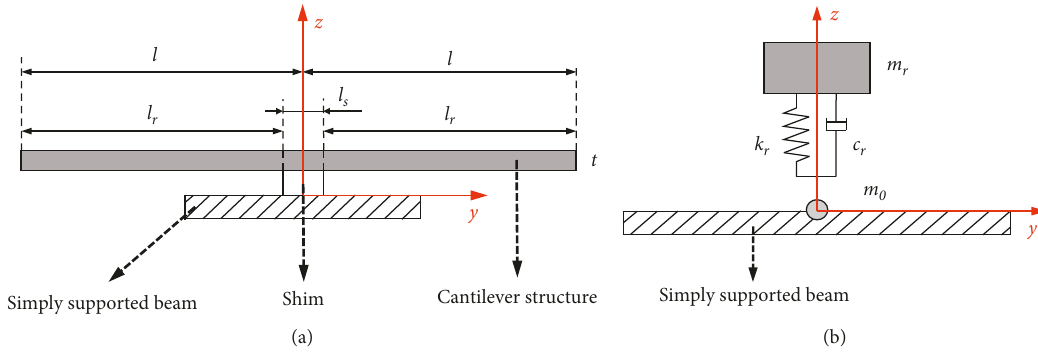
Figure 2: (a) Schematic diagram of the beam-like resonator. (b) Simplified equivalent